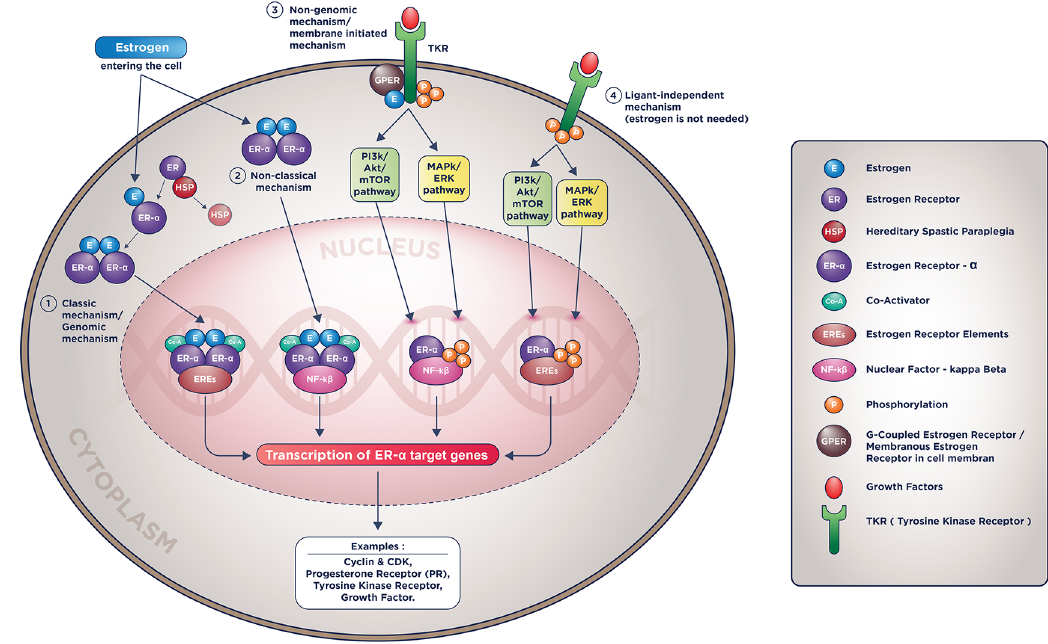
Figure 1. ER- α molecular mechanisms of